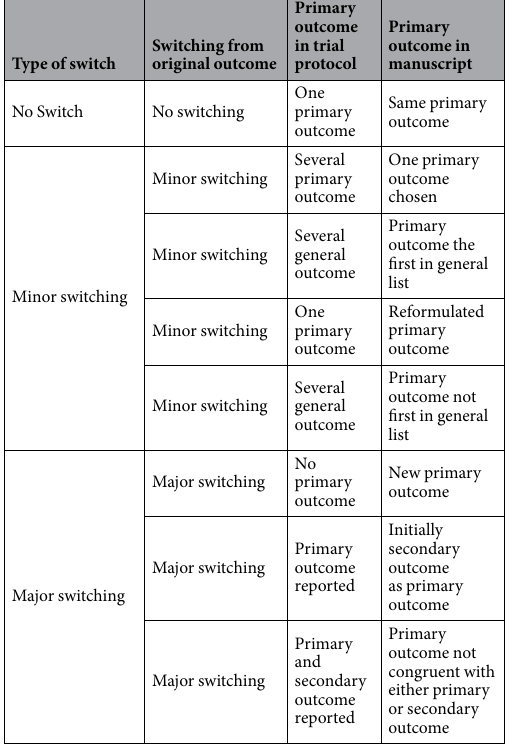
Table 1. Definition of